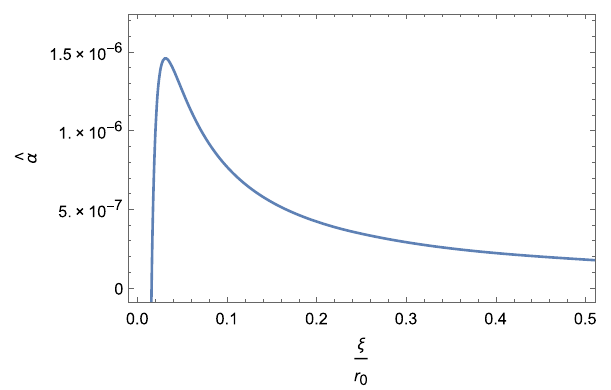
values of closest approach resembles approximately with the optical radius of the respective galaxies measured out to the isophotal level. For the insightful interpretation of the magni- tudes of f ( R ) lensing angle plots, we compare them with the lensing angle profiles obtained according to the generalized pseudo-isothermal model in the next